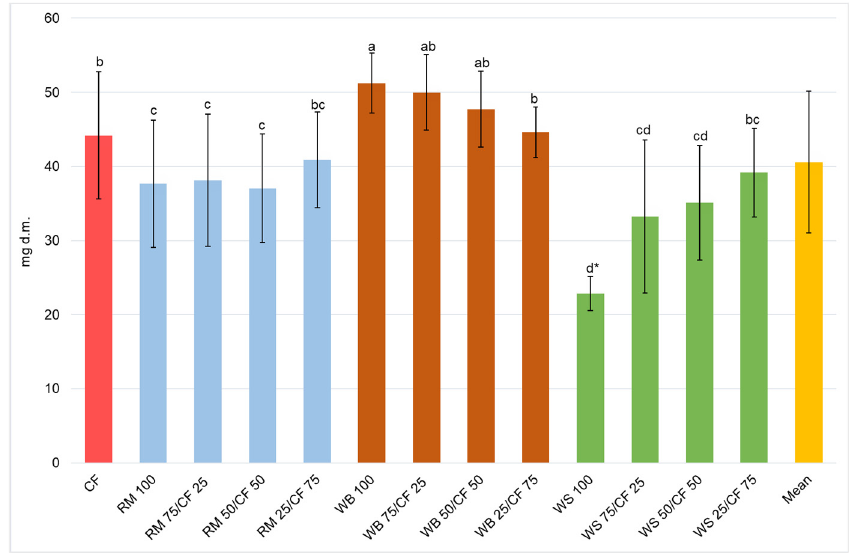
Figure 2. Individual final dry mass/weight of yellow mealworm larvae depending on the experi- mental diet. a,b,c . . . —letters indicate that values are statistically different (Tukey’s test at p < 0.05), (* the mean of 2